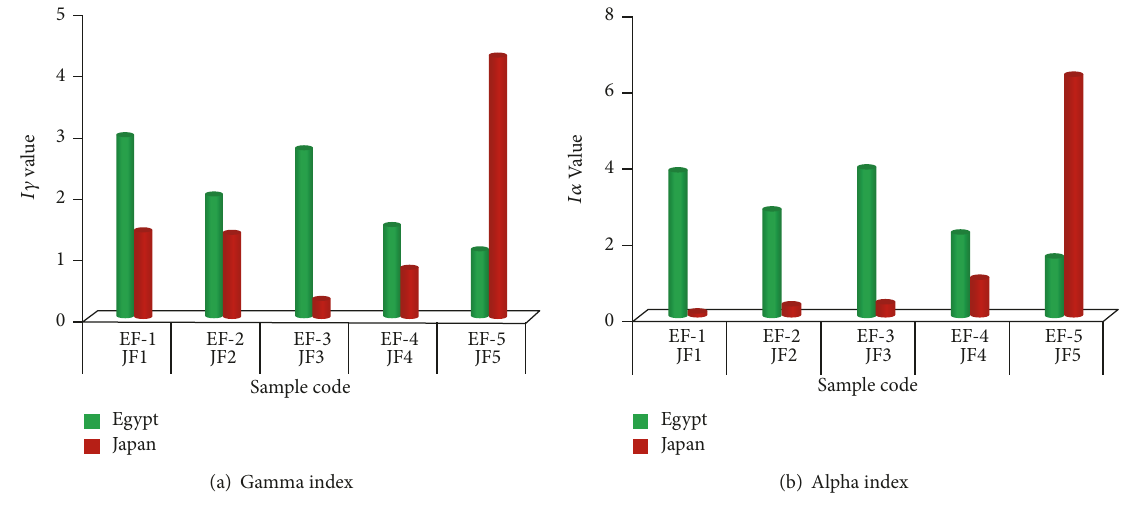
Figure 4: Comparison of gamma and alpha indexes of Egyptian and Japanese fertilizers. Table 7: Comparison of radiological indexes in the present work and their values in